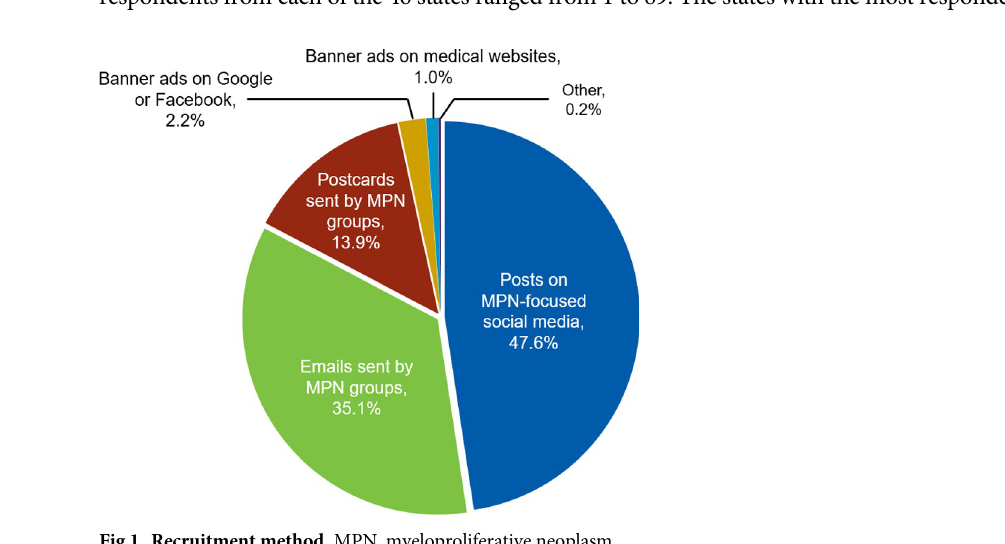
Fig 1. Recruitment method. MPN, myeloproliferative